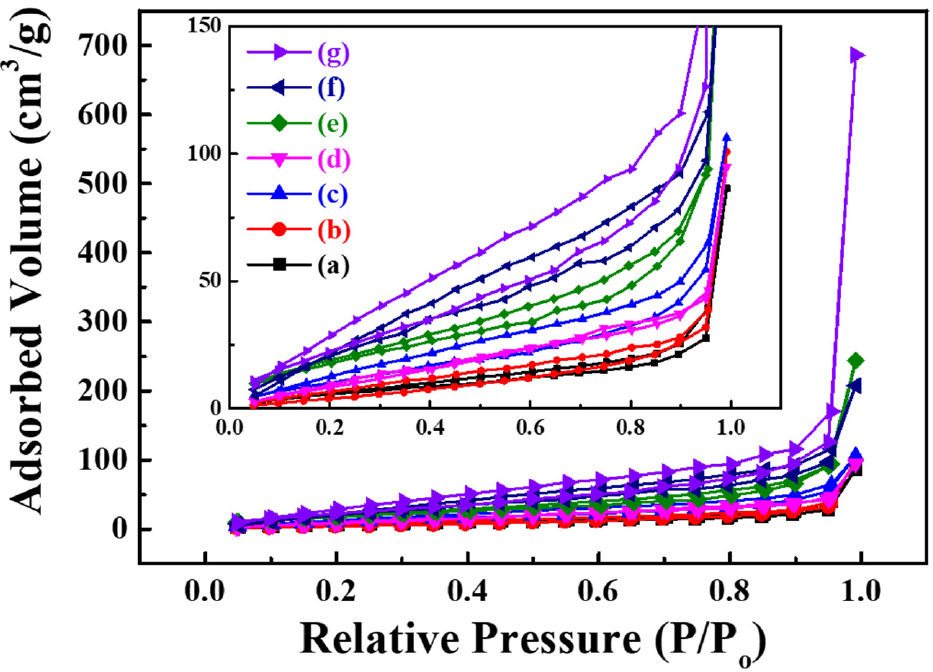
Figure 5. The BET curves of ( a ) neat PANI polymer matrix, ( b ) 2.5 wt% PANI/hollow In 2 O 3 nanofiber, ( c ) 5 wt% PANI/hollow In 2 O 3 nanofiber, ( d ) 10 wt% PANI/hollow In 2 O 3 nanofiber, ( e ) 15 wt% PANI/hollow In 2 O 3 nanofiber, ( f ) 20 wt% PANI/hollow In 2 O 3 nanofiber, and ( g ) 25 wt% PANI/hollow In 2 O 3 nanofiber composites. Table 1. Data of the specific surface area and the coating thickness of the PANI layer for the PANI/hollow In 2 O 3 nanofiber composites.